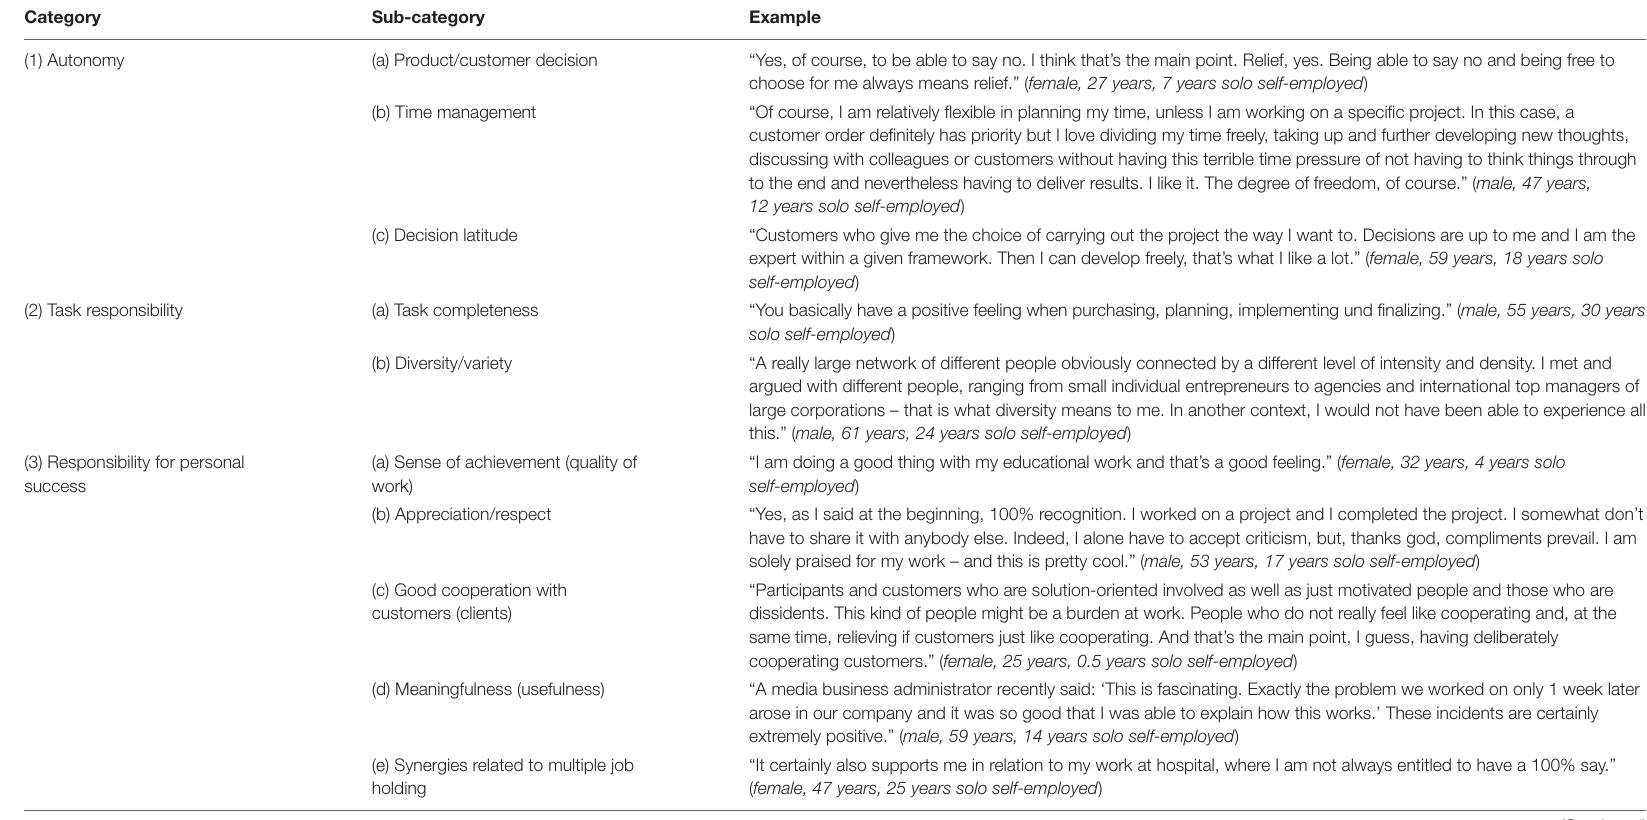
TABLE 3 | Resources provided by solo